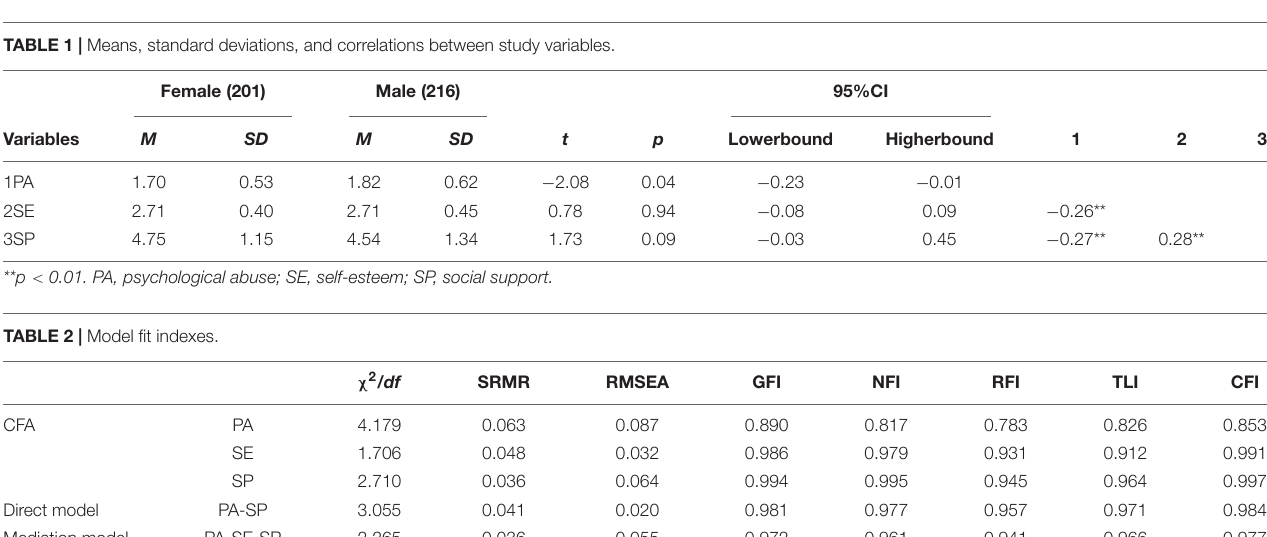
TABLE 1 | Means, standard deviations, and correlations between study variables.